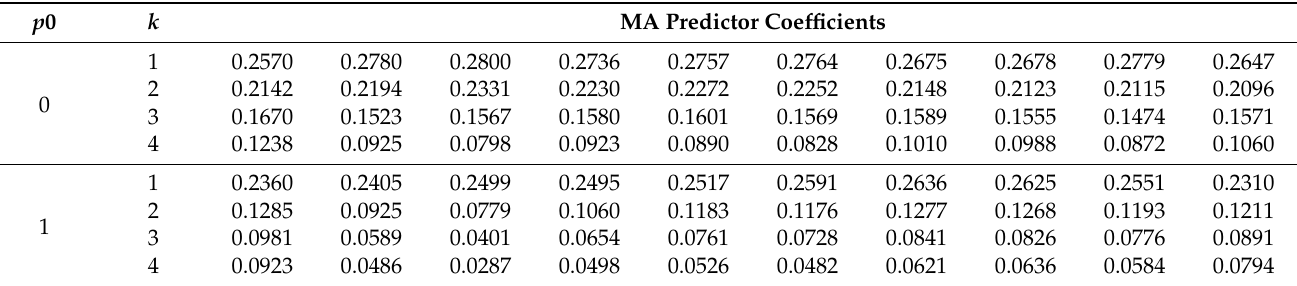
Table 1. The value of the MA predictor coefficients.